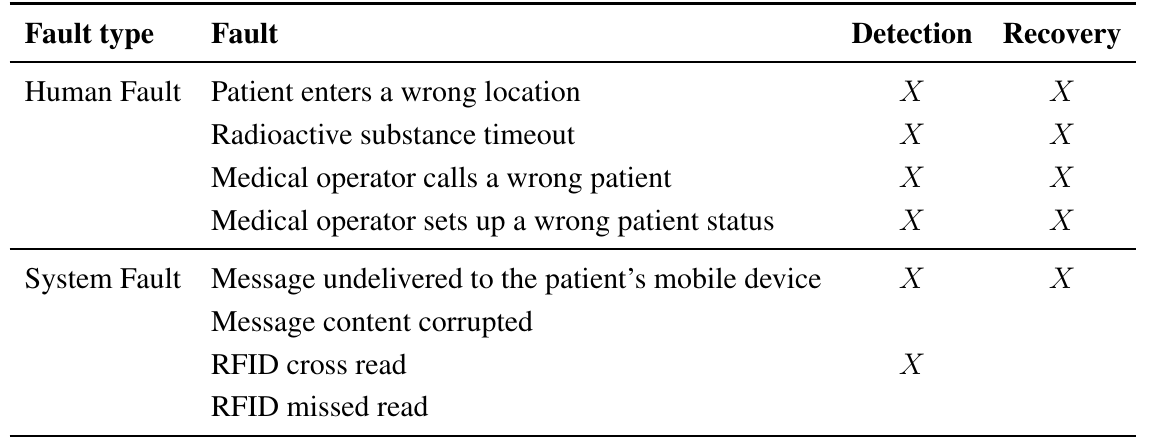
Table 5. Example of fault coverage for Case Study